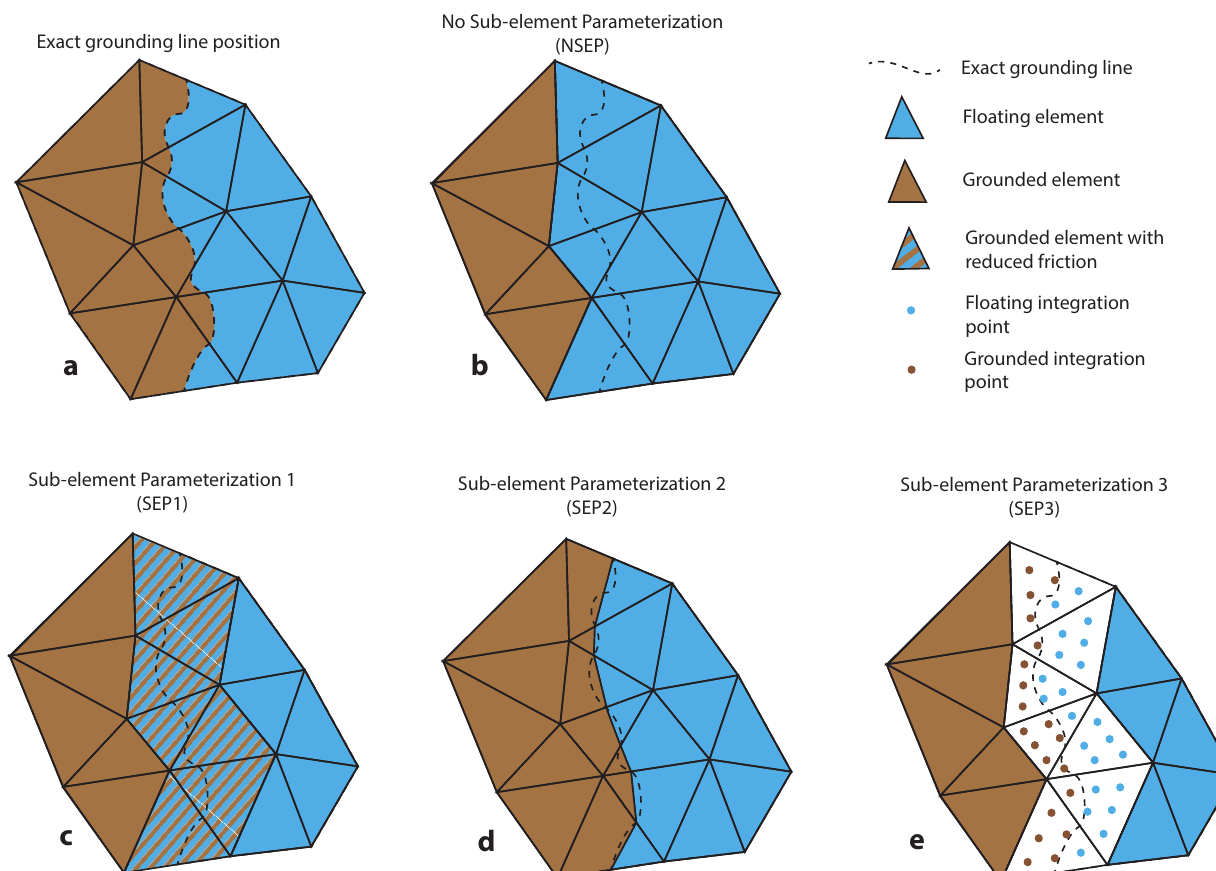
Figure 1. Grounding line discretization. Grounding line exact location (a) , no sub-element parameterization (NSEP, b ), sub-element param- eterization 1 (SEP1, c ), sub-element parameterization 2 (SEP2, d ) and sub-element parameterization 3 (SEP3, e